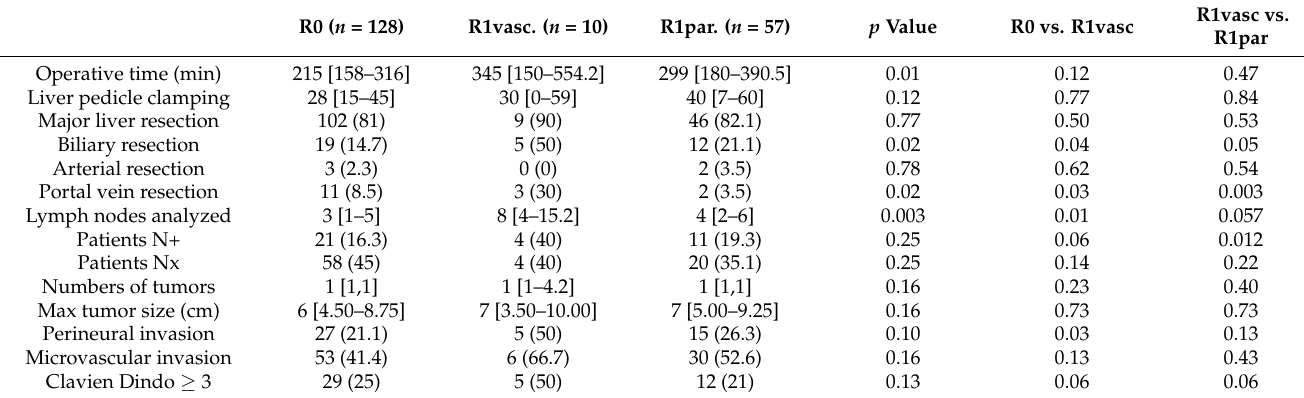
Table 2. Peri- and postoperative data according to R status.